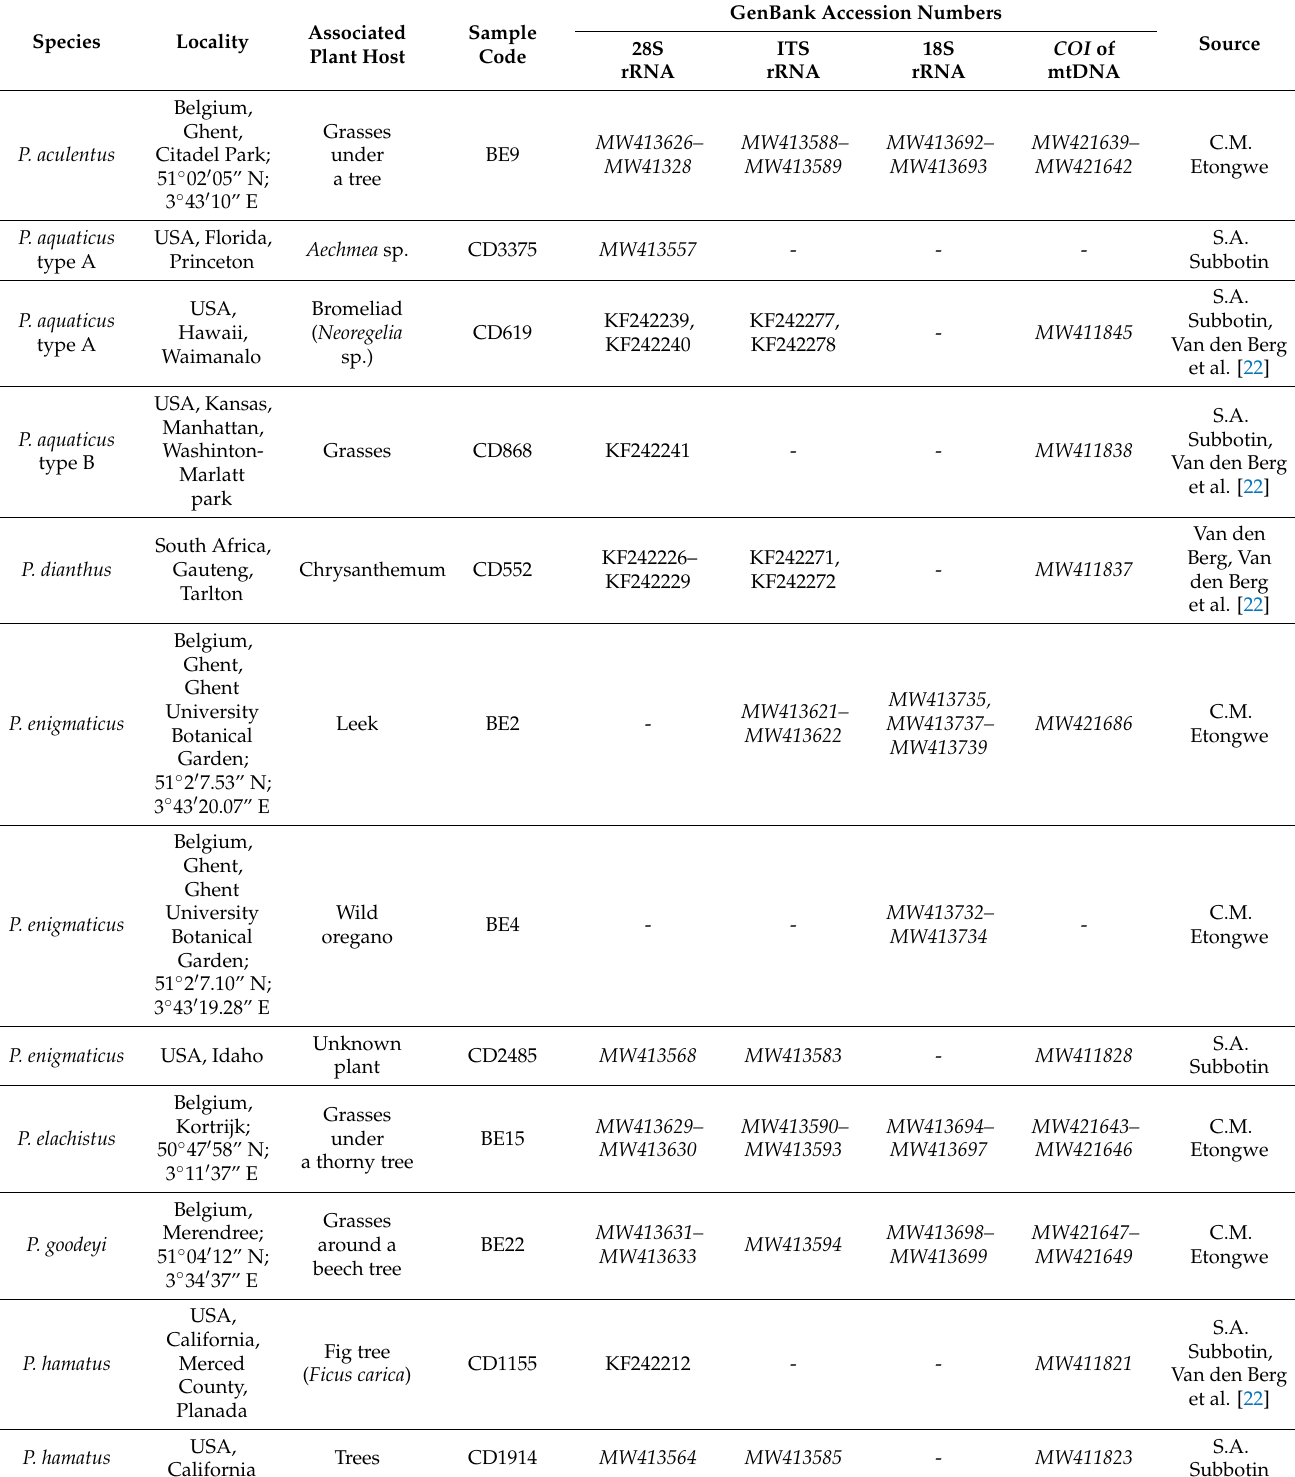
Table 1. List of Paratylenchus populations included in this study. Accession numbers of three ribosomal RNA genes (D2-D3 of 28S, ITS and 18S) and a mitochondrial gene ( COI ) fragments are provided for 18 identified and 14 unidentified Paratylenchus species. Accession numbers in italics are ones generated in this